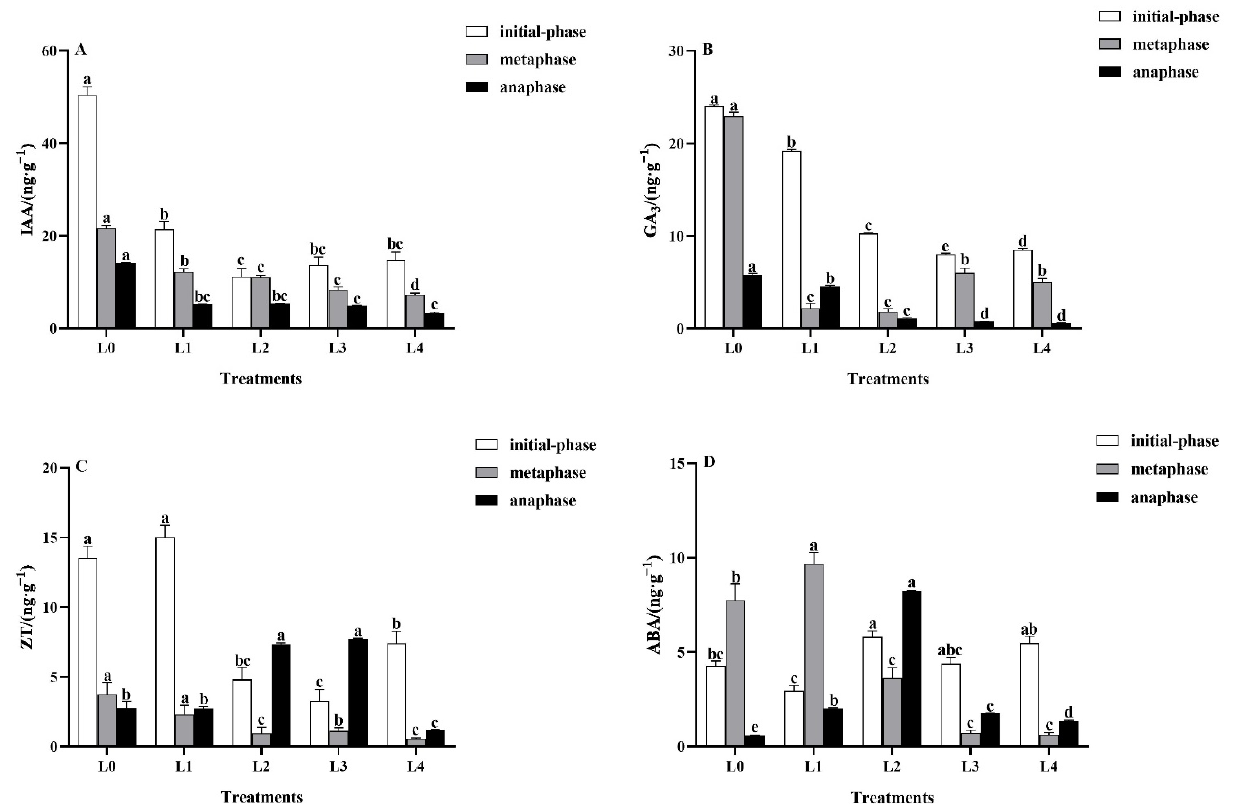
Figure 6. Effects of different light intensities on leaf endogenous hormone of Ma bamboo. Hormones include IAA ( A ), GA 3 ( B ), ZT ( C ), and ABA ( D ). Note: L0, L1, L2, L3, and L4 refer to 100%, 40%, 30%, 20%, and 10% of natural light, respectively. Values are the means ± SE of four replicates per treatment. Different letters indicate significant differences between treatments at the same shooting period ( p < 0.05).